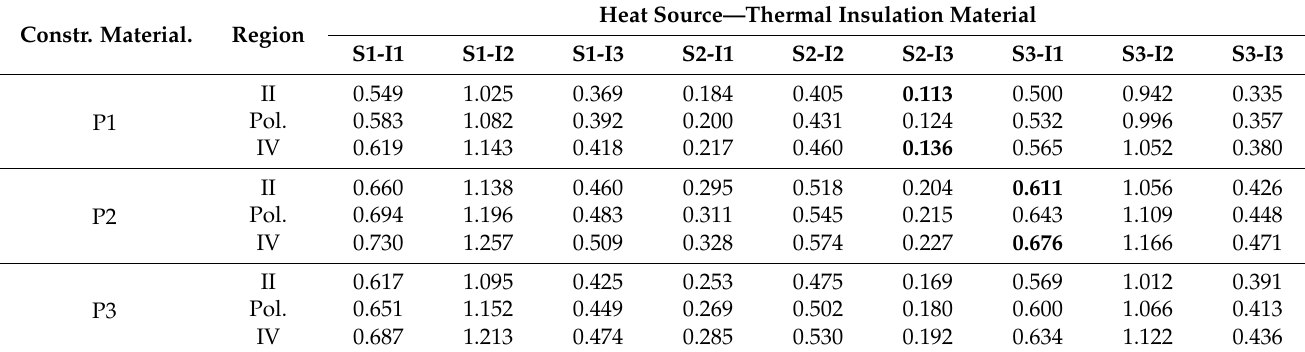
Table 8. Ecologically optimal thermal insulation thickness d Eopt